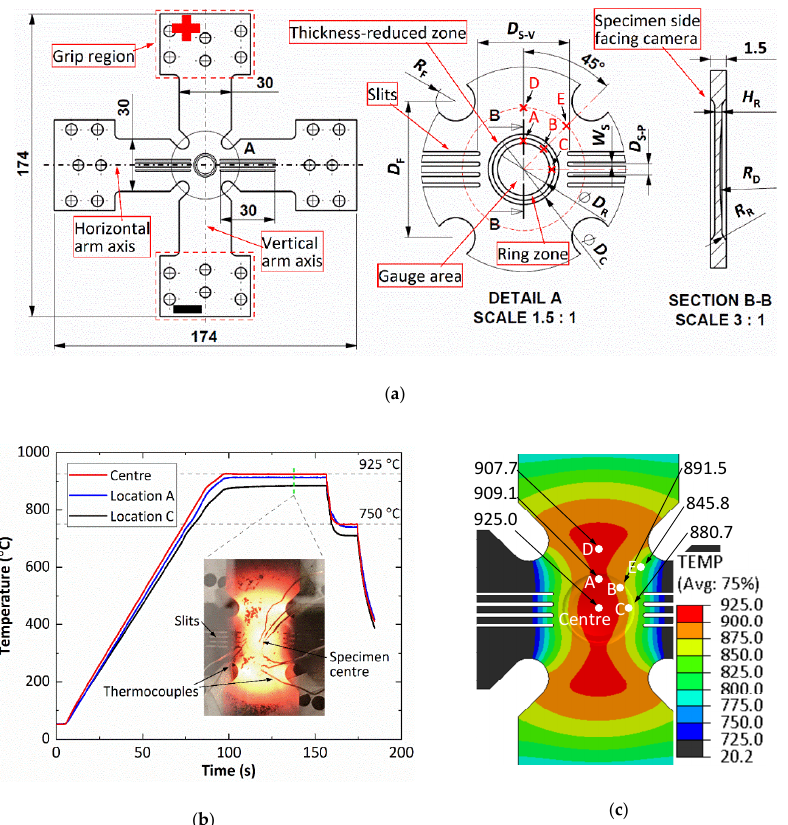
Figure 6. Cruciform specimen design and heating for formability evaluation under hot-stamping conditions [7]: ( a ) cruciform specimen design together with the heating scheme using the direct resistance heating method, ( b ) temperature evolution at the preselected locations with the inset showing the temperature distribution in the gauge area of a boron steel specimen, and ( c ) temperature distribution simulated using thermal FE model under the same